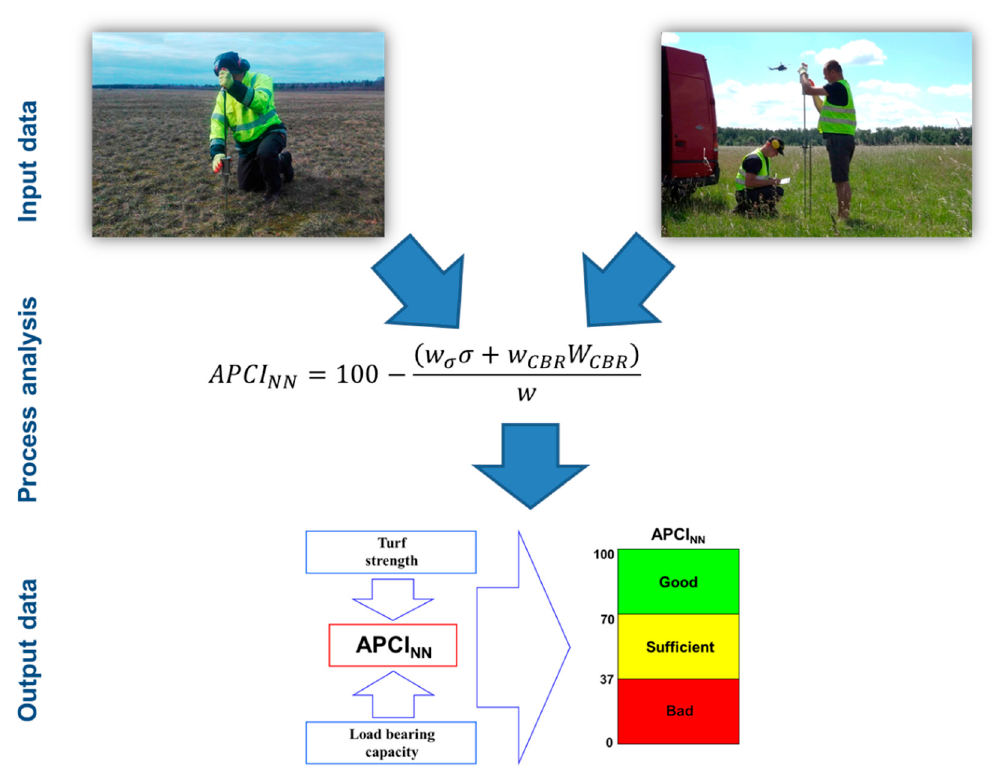
Figure 9. Procedure for technical evaluation of AFE natural pavement with APCI method.